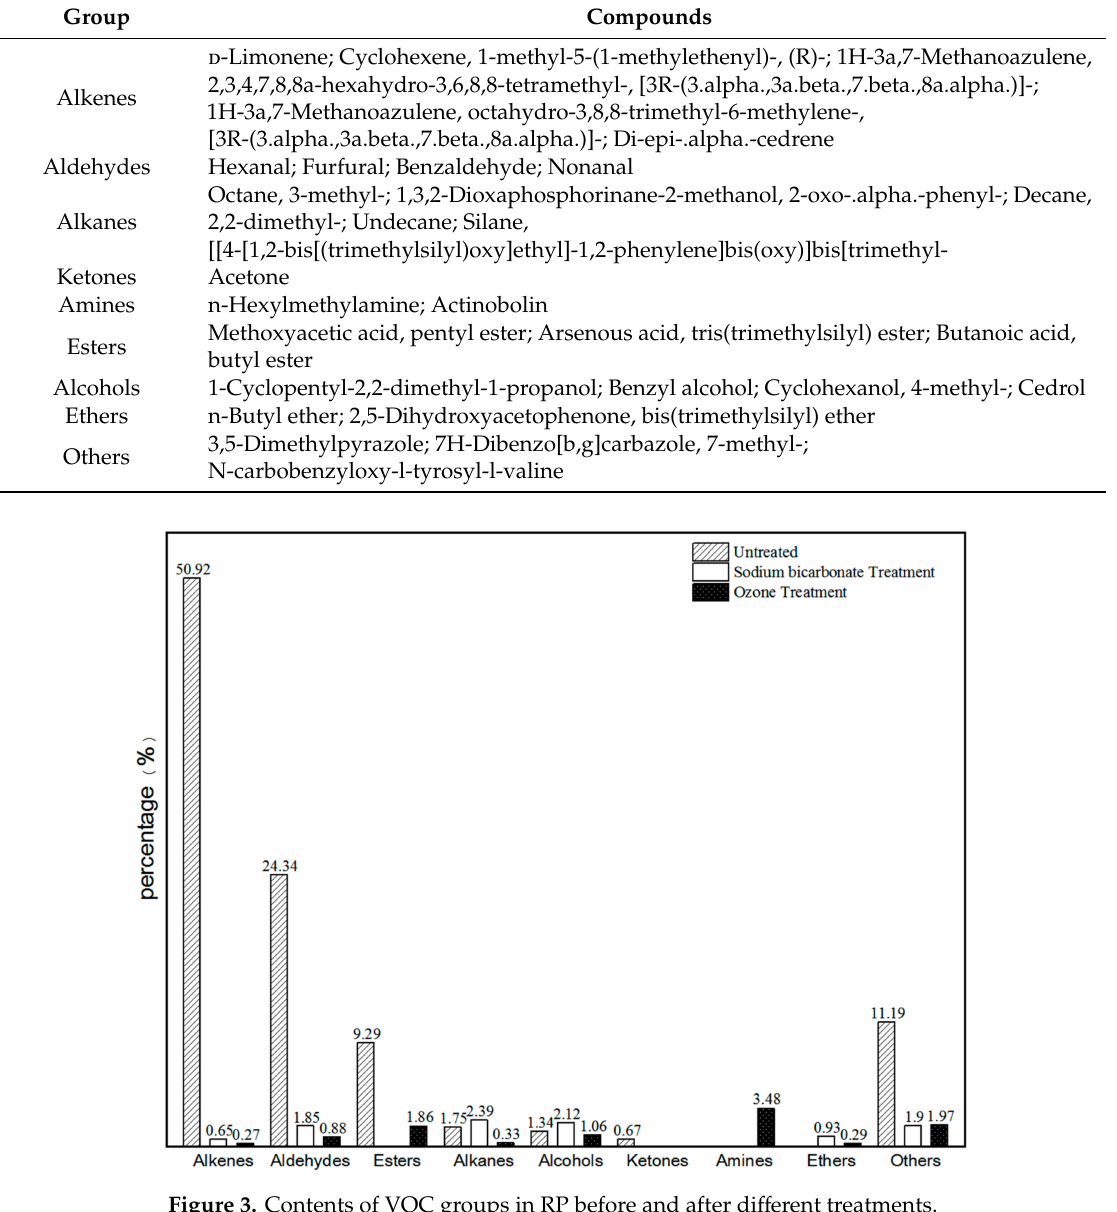
Figure 3. Contents of VOC groups in RP before and after di ff erent